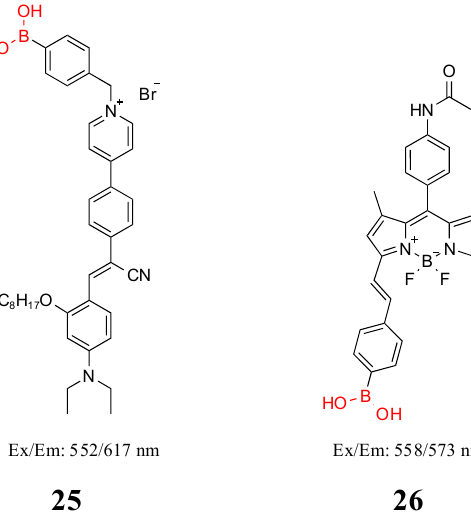
Figure 11. Schematic complex of a boronic-acid-modified poly(amidoamine) dendrimer structure and application. Reproduced with permission from Ref. [76]. Copyright 2019, American Chemical Society.